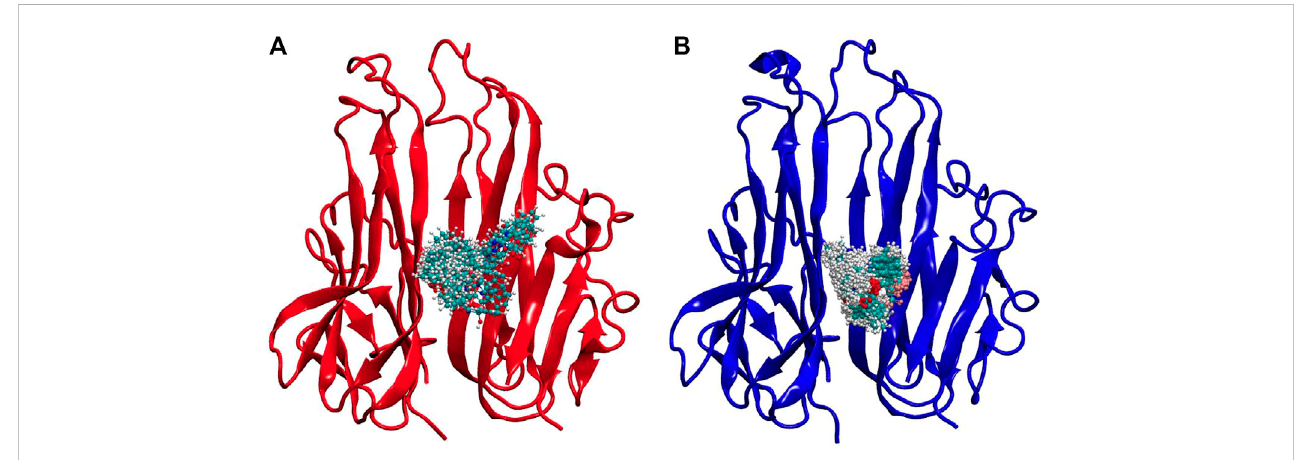
FIGURE 7 Simulation snapshots of ligands in (A) TNF-compound complex and (B) TNF-inhibitor complex. The ligand snapshots have been taken at every 1 ns of simulation time, while the protein is fi xed at 0 ns (initial structure). The ligand remained in a bound state in both systems, however, (A) Is slightly fl exible, occupying somewhat more space in the binding site due to increased ligand size, while (B) Is highly compact.